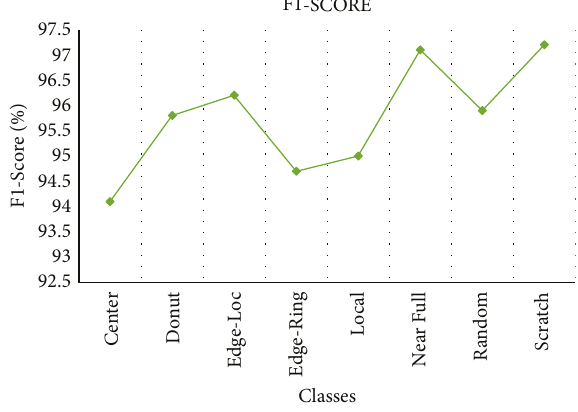
Figure 10: Graphical plot of ShuffleNet-v2-CNN’s F1-score performance.